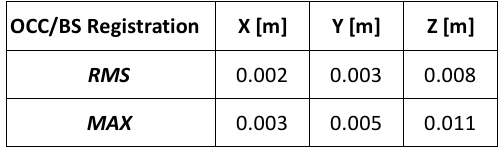
Table 2. Magnet Collage residual and maximum deviation of